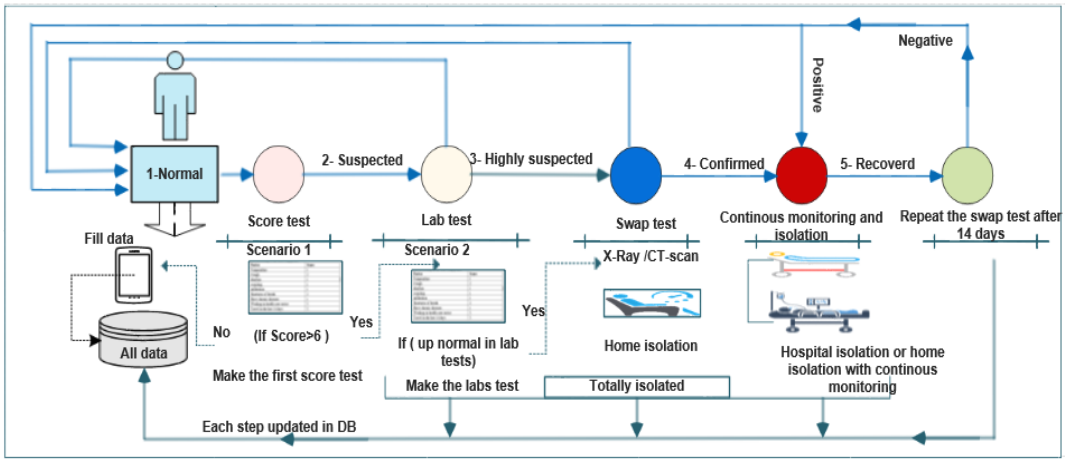
Figure 5. Patient’s side.